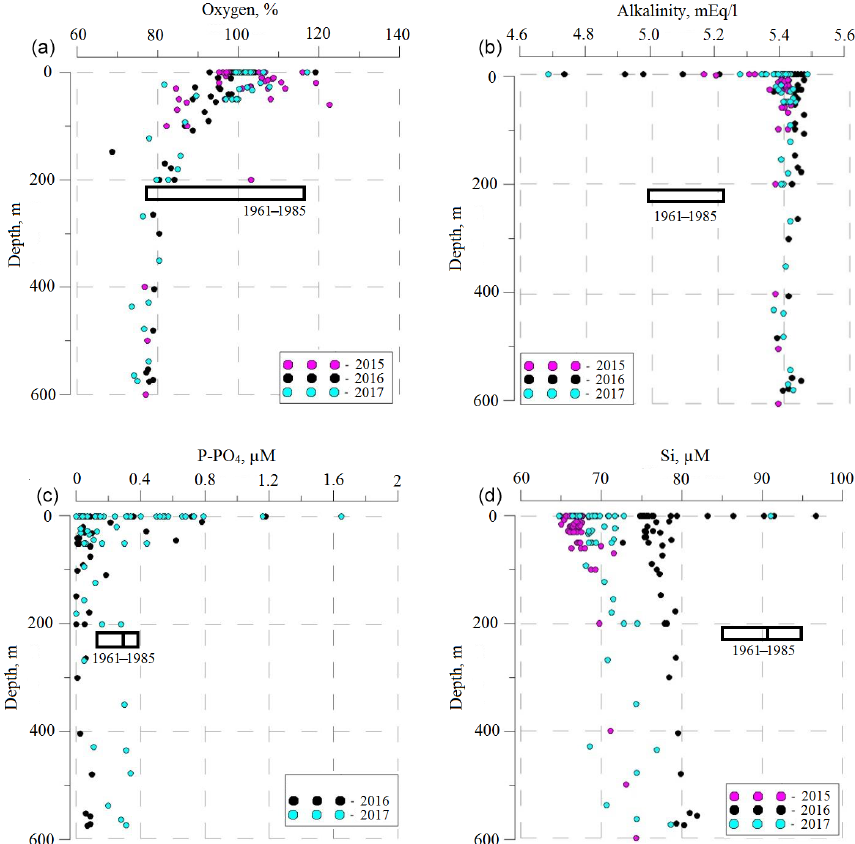
Figure 9. Vertical distributions of oxygen saturation (a) , alkalinity (b) , phosphates (c) , and silicates (d) in different surveys. Black boxes indicate the typical range for waters below 200m in 1961–1985 (Kadyrov, 1986), except for oxygen, where the box indicates the overall range. The vertical lines in the boxes show average values (where